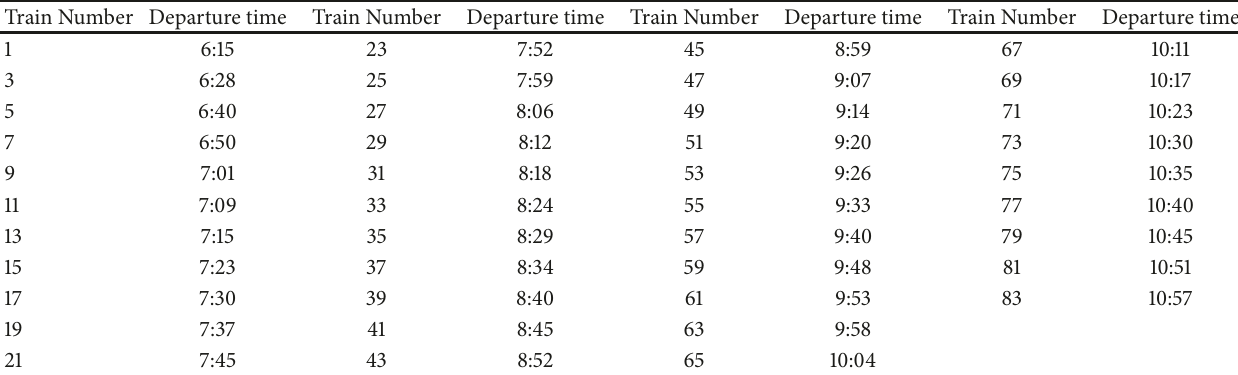
Table 2: Departure time at the starting station for up trains.